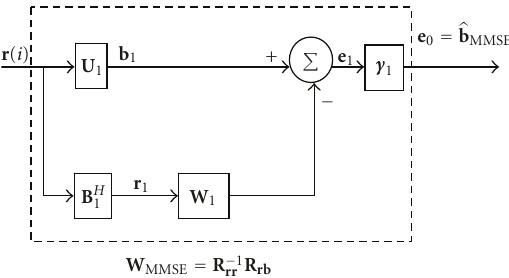
Figure 1: Block diagram of the first-stage orthogonal decomposi- tion process of the MMWF receiver.